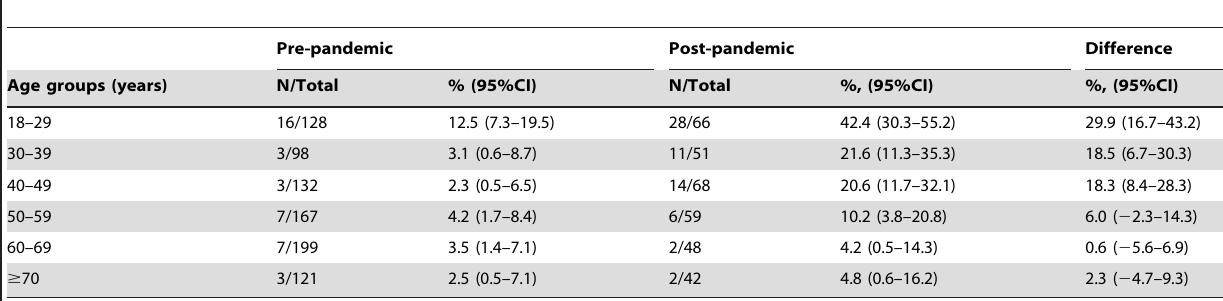
Table 1. Number and proportion of observations with reactive antibody titre $ 40 by age groups in pre- and post-pandemic samples and difference in proportions between pre- and post-pandemic